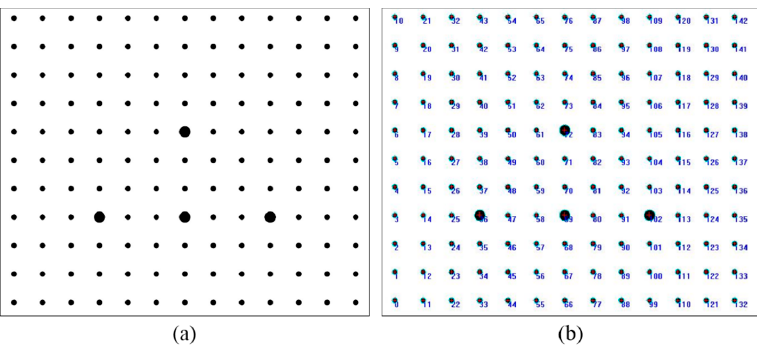
Figure 2. ( a ) Target pattern of the planar board used for zoom lens calibration; ( b ) An example of automatic extraction and encoding of target points.